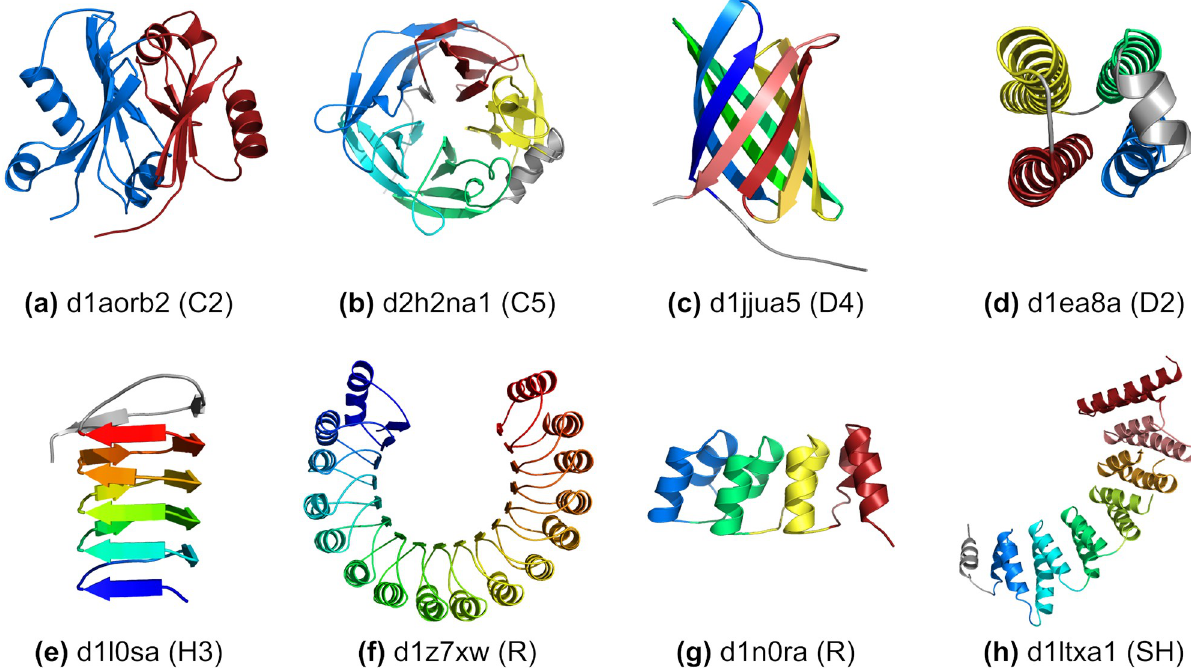
Fig 1. Examples of protein globular domains with internal symmetry. Protein domains are labeled with SCOP domain identifier [26, 27]. a) N- terminal domain of aldehyde ferredoxin oxidoreductase with 2-fold rotational symmetry (C2) of an alpha+beta motif; b) 5-bladed beta propeller with a helical insertion between second and third blades with 5-fold rotational symmetry (C5) of a 4-stranded beta-sheet motif; c) Beta-barrel with 8 beta strands in a 4-fold dihedral symmetry (D4) of single stranded motifs; d) 4-helical bundle with dihedral symmetry connectivity (D2) of single helical motifs; e) Beta-helix with single stranded right-handed helical symmetry (H3); f) Leucine rich repeats with open rotational symmetry (R) of 16 up and down alpha-beta motifs; g) Designed Ankyrin repeat protein with 4 translational repeats (R) of double helical motifs; h) Alpha-alpha right-handed superhelix (SH) of double helical motifs. Repeats are colored from blue, N-terminal, to red, C-terminal. Non-repeating parts of the structure are colored in grey.